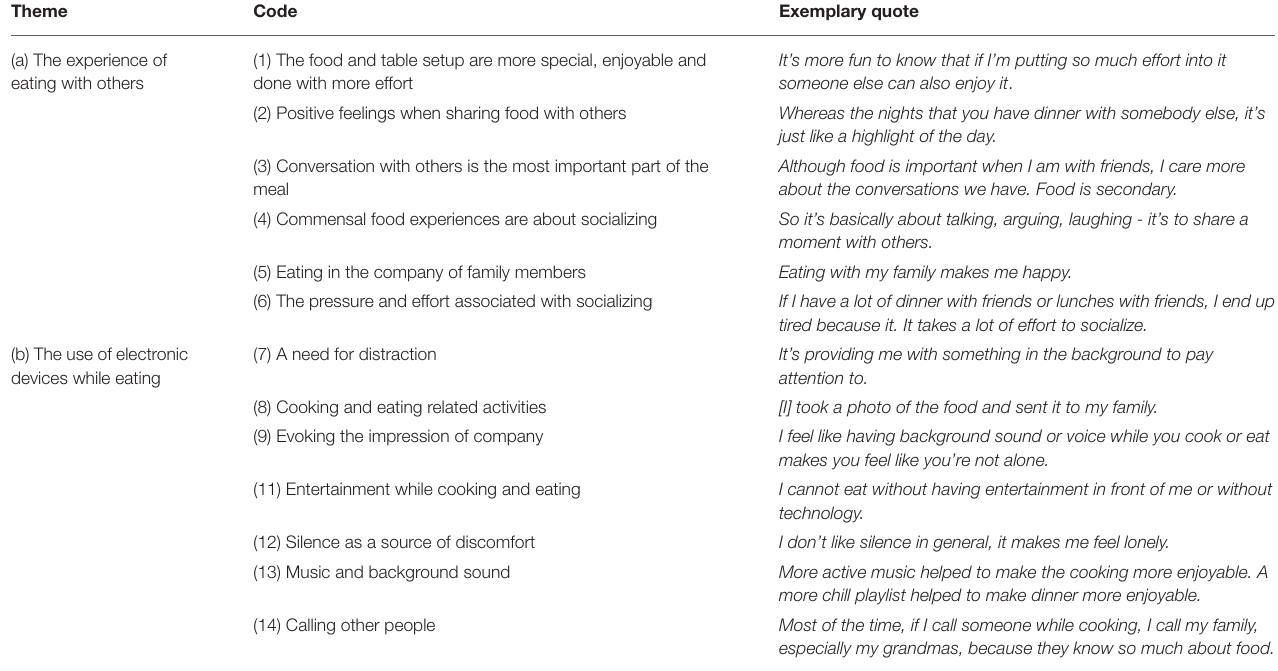
TABLE 4 | Overview of themes, codes, and exemplary quotes. Theme